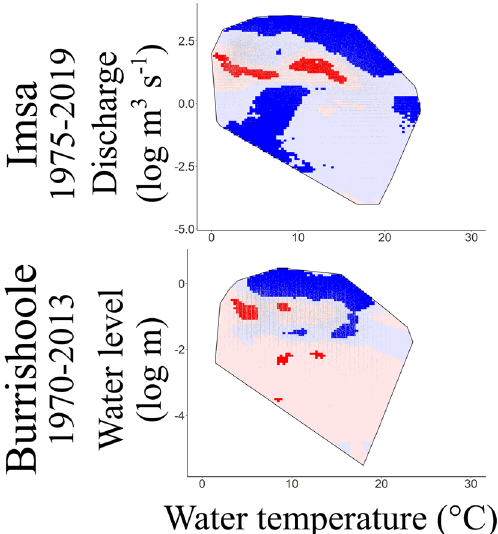
Figure 4. Two-dimensional heatmaps of water temperature (X-axis; °C) and log-transformed discharge/water level (Y-axis; log m 3 s −1 or log m) associations for the Imsa and Burrishoole rivers at the annual scale. Water temperature × discharge/water level associations that have become more or less frequent over the study period are shown in blue or red, respectively. Light and dark colours correspond to non-significant and significant trends, respectively (e.g., dark red corresponds to significant decreasing trends, light blue to non-significant increasing trends). The grey line delineates the convex hull ( i.e. , the smallest space encompassing all points of the annual dataset). See Fig. S2 for the results at the seasonal